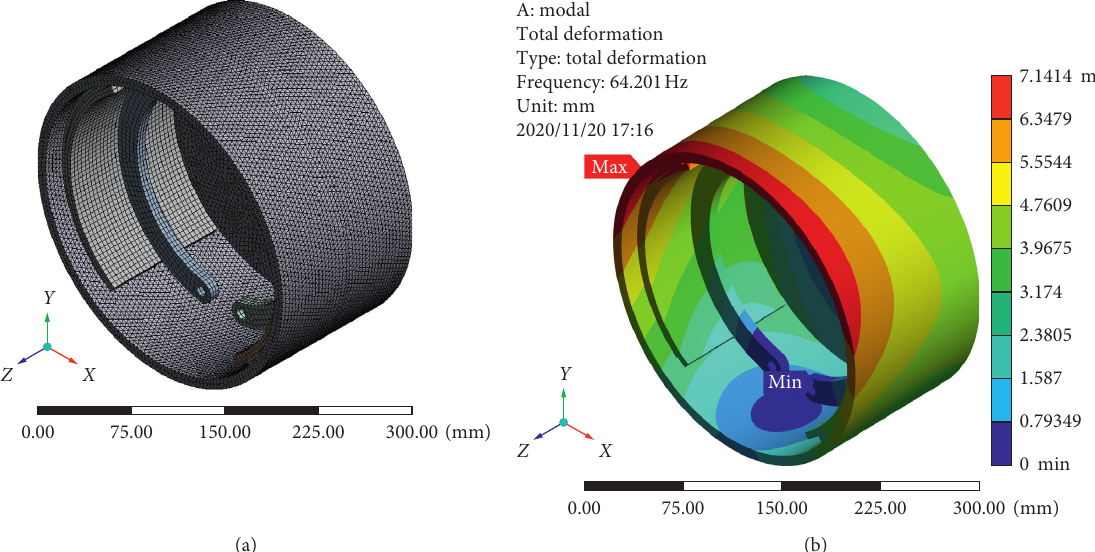
Figure 11: The FEA result of the drum brake model. (a) The mesh of the drum brake model. (b) The natural frequency of the drum brake.